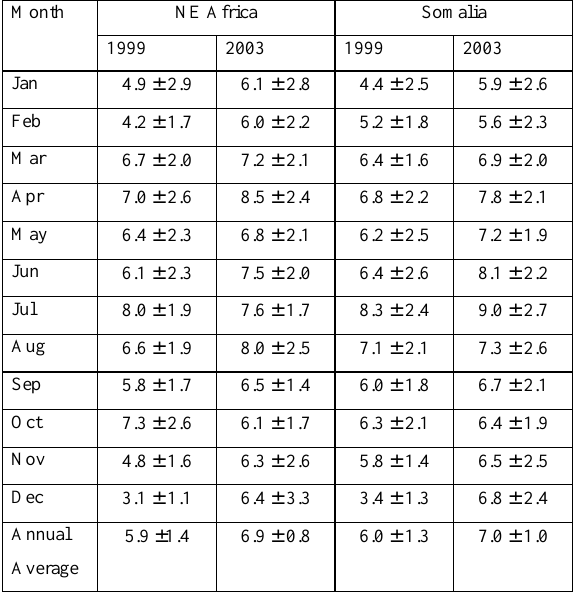
Table 3. Comparison of Monthly Mean IDDI (K). Table-3. Comparison of Monthly Mean IDDI (K) NE Africa Somalia